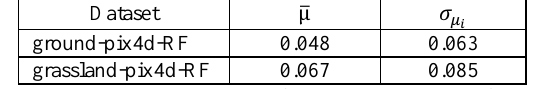
Table 3. Accuracy measures of DIM point cloud after pre- processed by a ranking filter. (Unit: m)